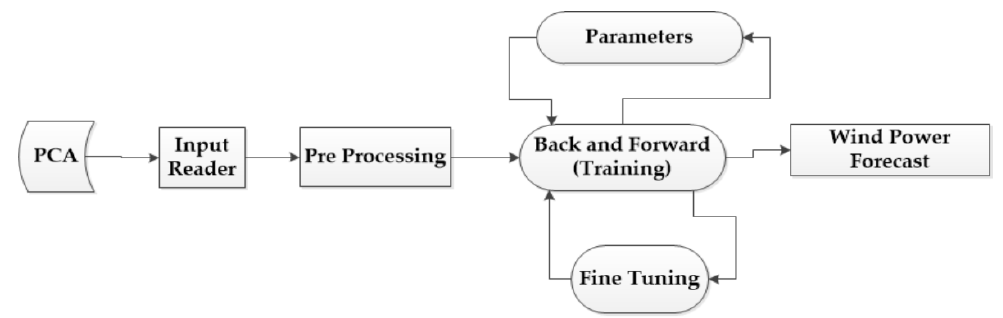
Figure 4. The applied loading diagram of the full-scale static testing. Table 2. The target load for the five loading positions.